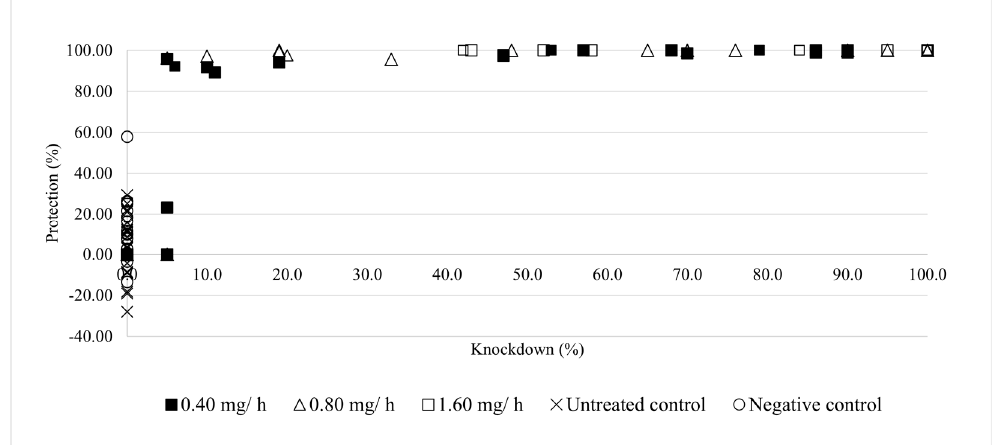
Figure 8. Relationship between knockdown and percent protection for Ae. albopictus across the five treatment groups in Experiment 2.